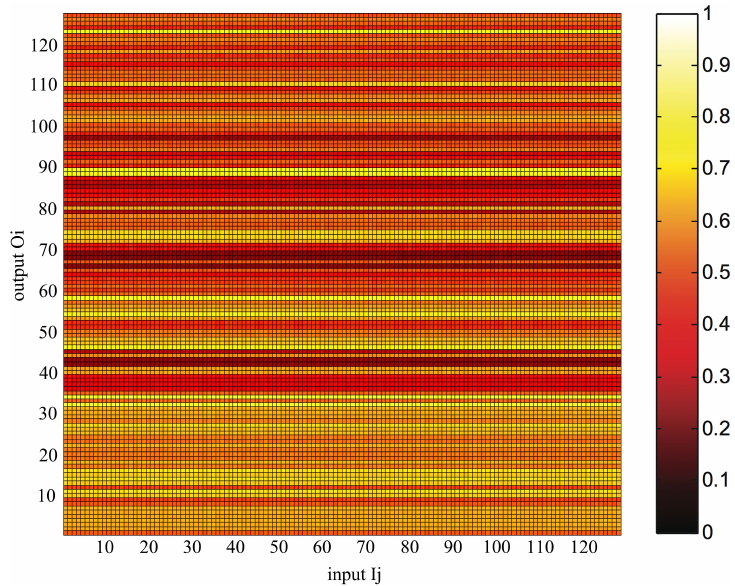
Figure 8. The conditional probability map of P( O